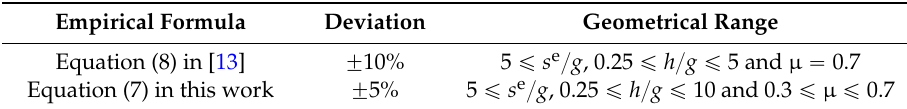
Table 4. The comparisons of the empirical formulas for the capacitance compensation term of etching hole in comparison with the simulation by the commercial software ANSYS.